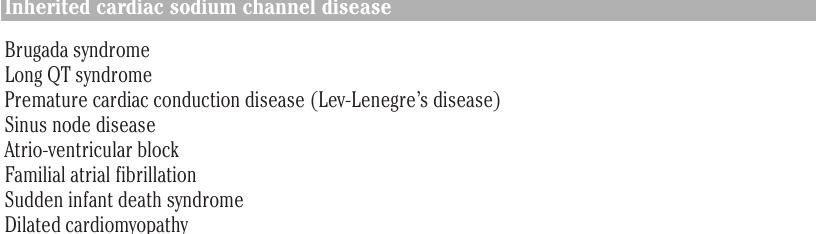
Table 3. Clinical syndromes associated with SCN5A mutations. Inherited cardiac sodium channel disease Atrio-ventricular block Familial atrial fibrillation Sudden infant death syndrome Dilated